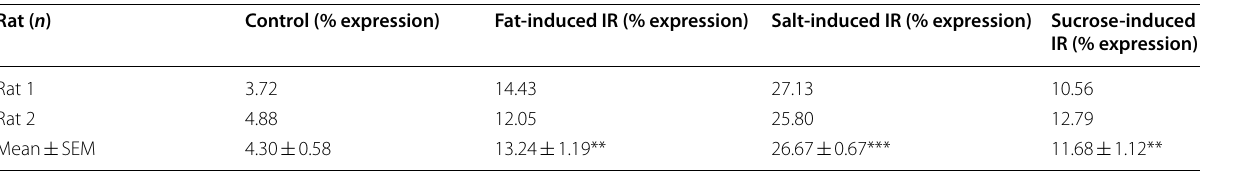
Table 3 GLUT4 percentage for individual animals/group